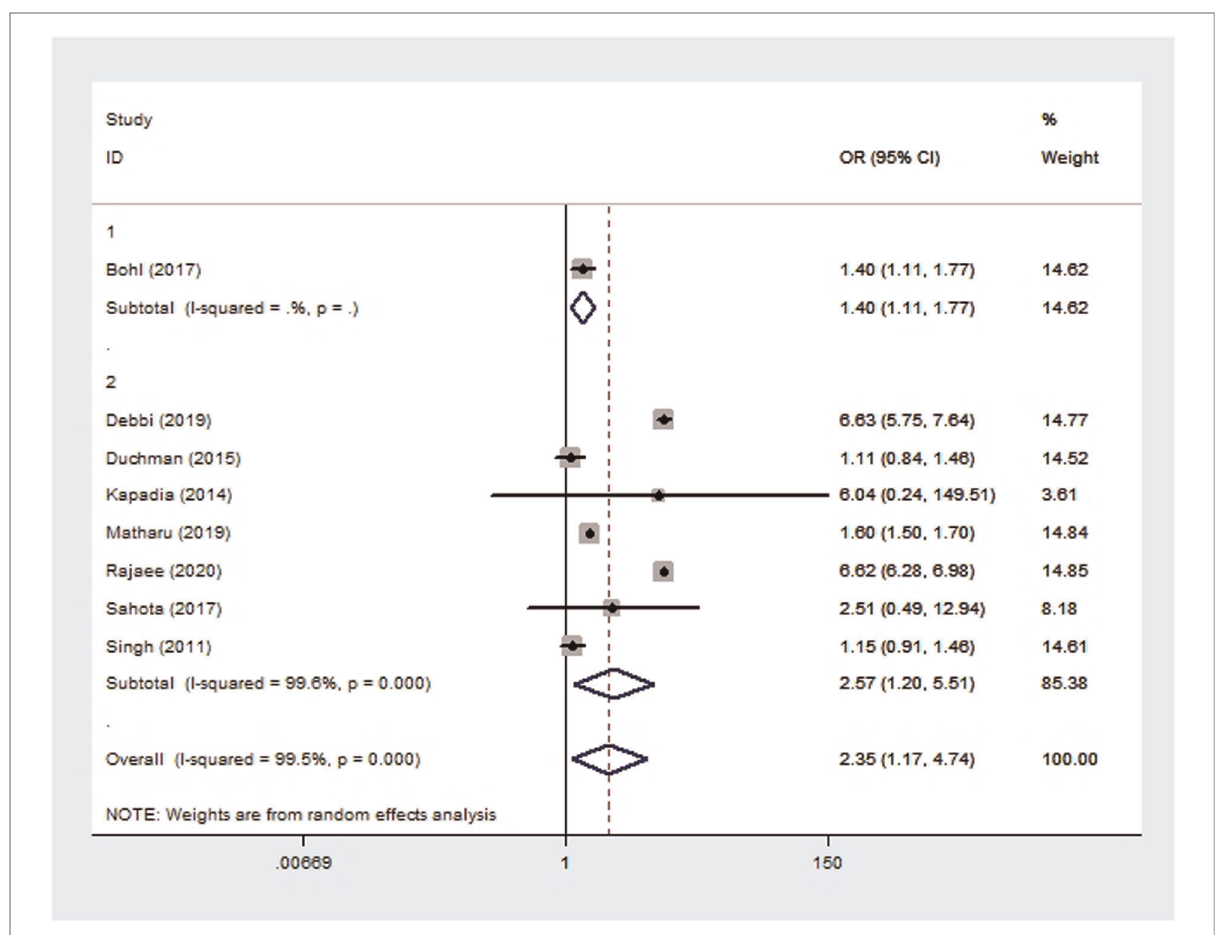
FIGURE 7 Forest plot of subgroup analysis for pneumonia based on study type (1: case-control study; 2: cohort